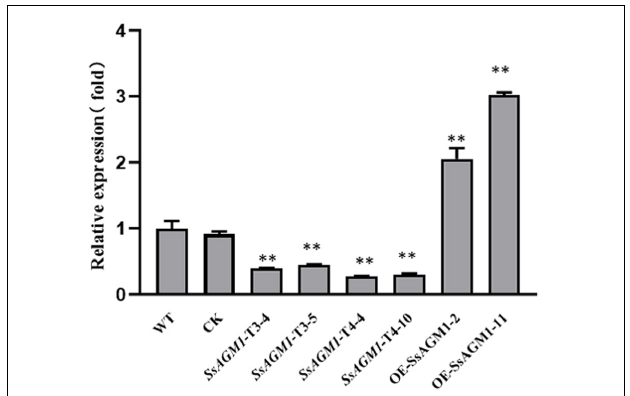
FIGURE 2 | The relative expression level of SsAGM1 in wild-type strain, control strain, gene-silenced transformants, and overexpression transformants was measured by RT-qPCR. The SsActin in each sample was used as an internal control. The relative expression of SsAGM1 in WT was set as “1.” Data represent means ± SD. One-way ANOVA, n = 3; ∗∗ represents significant difference from WT at p < 0.05. WT, Wild-type strain; CK, the control strain.